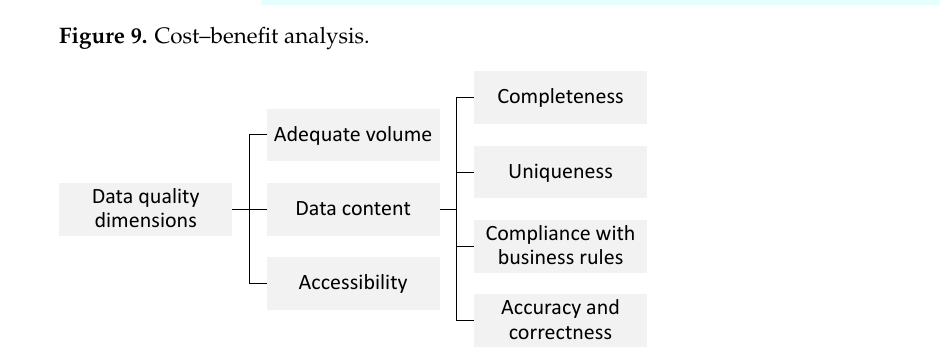
Figure 10. Data quality dimensions based on